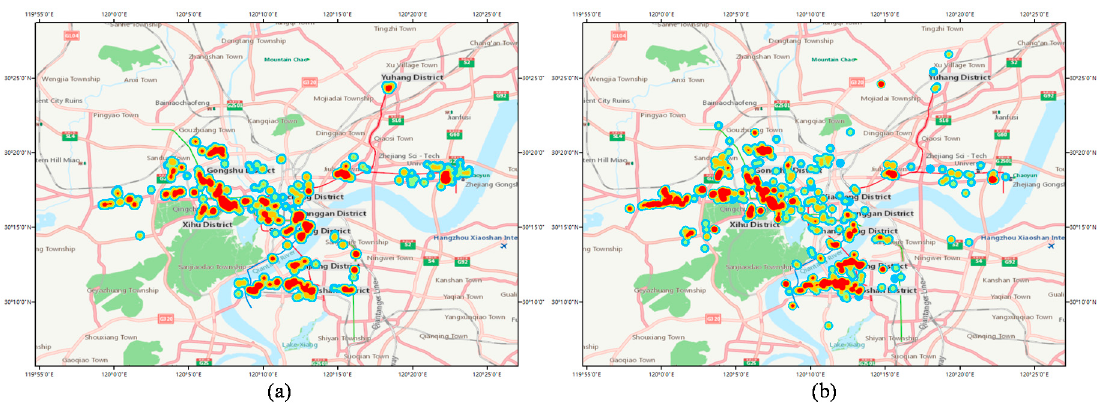
Figure 12. ( a ) Heat map made from the extracted work areas of this paper; ( b ) Heat map made from Internet and e-commerce companies.